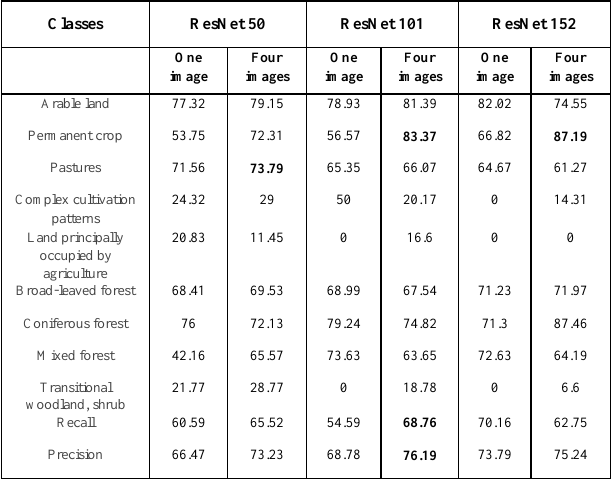
Table 2 . The precision of each class obtained from pre-trained ResNet 50,101,152 based on BEN dataset with fine-tuned networks on one and four sentinel-2 images